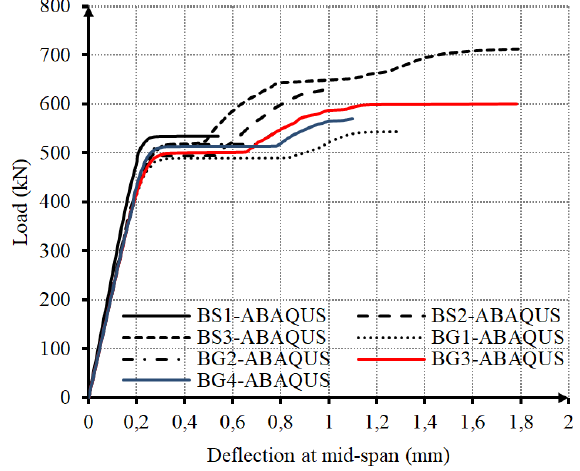
Figure 33: Load-deflection curve for deep beams